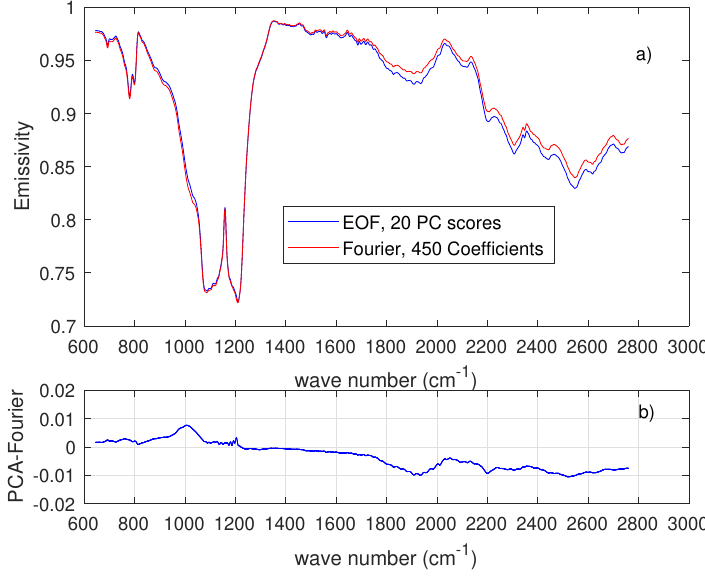
Figure 5. ( a ) Exemplifying the emissivity retrieval with Fourier series and PCA expansion. The results have been averaged over 70 IASI soundings recorded over a target area in the Algerian, Sahara desert in June 2007. Note how 20 PC scores are as much effective as 450 Fourier coefficients. ( b ) Difference between PCA and Fourier